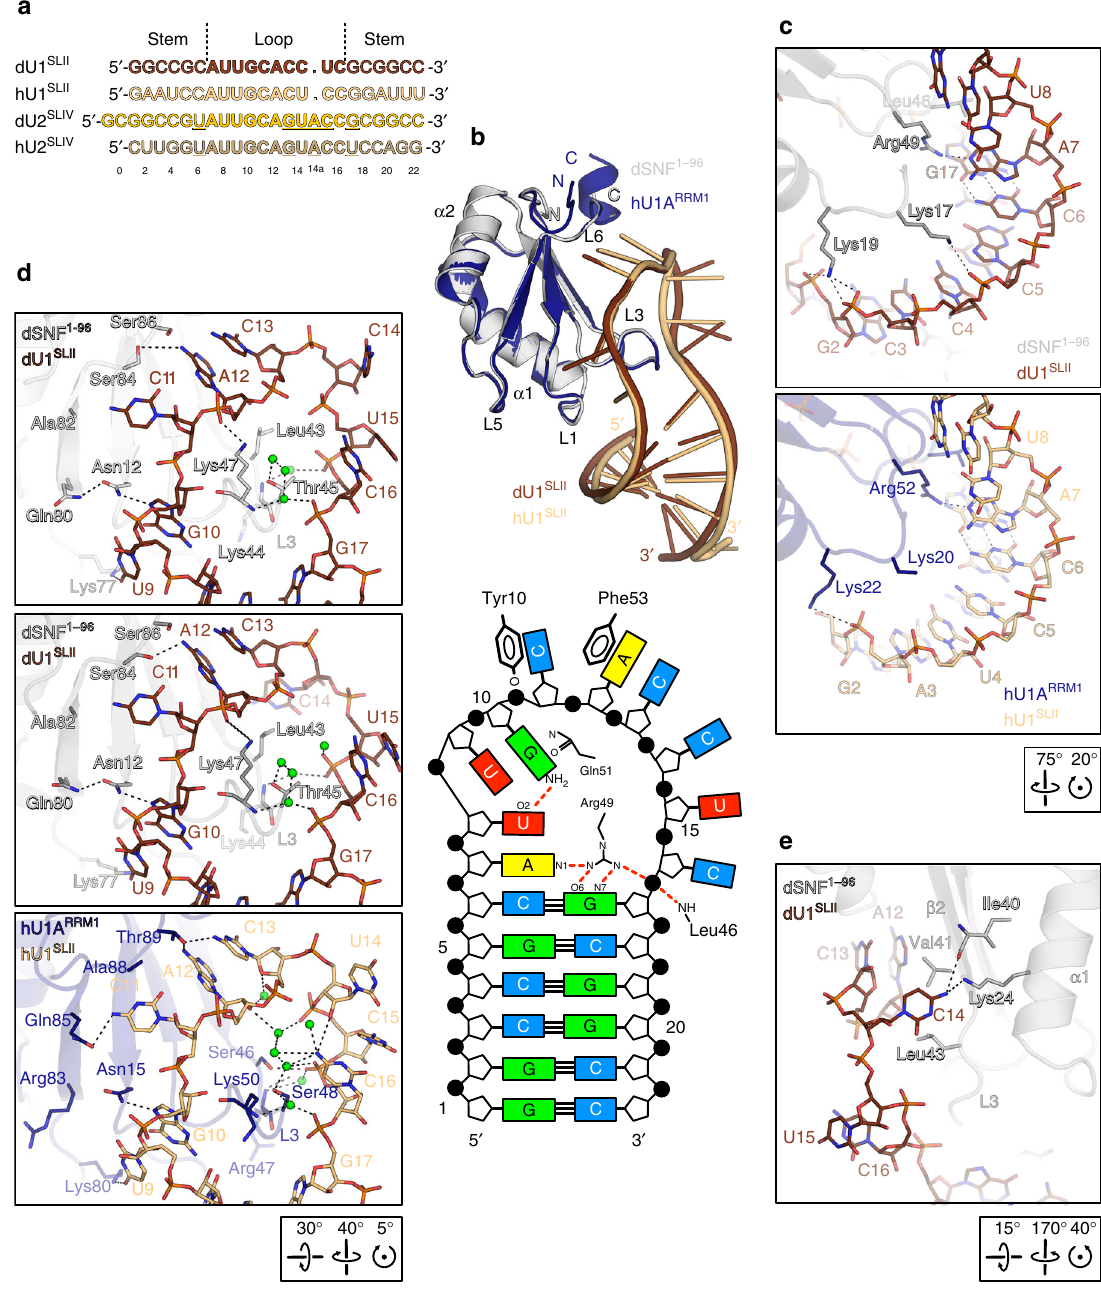
Fig. 3 dSNF 1 – 96 – dU1 SLII structure compared to hU1A RRM1 – hU1 SLII . a Alignment of dU1 SLII (brown), hU1 SLII (light orange), dU2 SLIV (gold) and hU2 SLIV (light brown) RNAs ( Drosophila RNAs as used in the present study; human RNAs as used in refs. 13, 14 ). Loop residues are in bold. Sequence differences in the loops and the loop-closing base pairs of U2 SLIV compared to U1 SLII in the Drosophila and human systems are underlined. b Top: hU1A RRM1 – hU1 SLII complex (dark blue/light orange; PDB ID 1URN, chains B and Q 13 ) superimposed on the crystal structure of a dSNF 1 – 96 – dU1 SLII complex (gray/brown) according to the hU1A RRM1 /dSNF 1 – 96 subunits. Orientation of dSNF 1 – 96 as in Fig. 1b. Bottom: Scheme of selected protein-RNA interactions in the dSNF 1 – 96 -dU1 SLII complex. c dSNF 1 – 96 contacts to the stem of dU1 SLII (top panel) and comparison to the human system (bottom panel). Lys20 C δ , C ε and N ε coordinates are not contained in the human structure. d dSNF 1 – 96 contacts to the dU1 SLII loop and comparison to the human system. e C14 of dU1 SLII fl ipped towards dSNF 1 – 96 in one of the complexes in the crystal. In this and the following fi gures: Stick representations are colored by atom type; carbon — color of the respective molecule; nitrogen — blue, oxygen — red, phosphorus — orange, sulfur — yellow; water oxygens are shown as green spheres; dashed lines represent hydrogen bonds or salt bridges. Orientations relative to Fig. 1b are indicated by boxed rotation dSNF 1 – 101 backbone dynamics upon binding dU1 SLII or are an exception; in the free protein, residues 89 – 101 ( α 3 and C- dU2 SLIV . Fast timescale (ps-ns) backbone dynamics of dSNF 1-101 terminus) are mostly disordered on this timescale, as shown by hetNOE experiments. When the hairpins are bound, residues in α 3 are quite similar in the absence or presence of RNA (dU1 SLII or become less dynamic (Supplementary Fig. 1). Those residues do not dU2 SLIV ; Supplementary Fig. 1). C-terminal regions of the protein